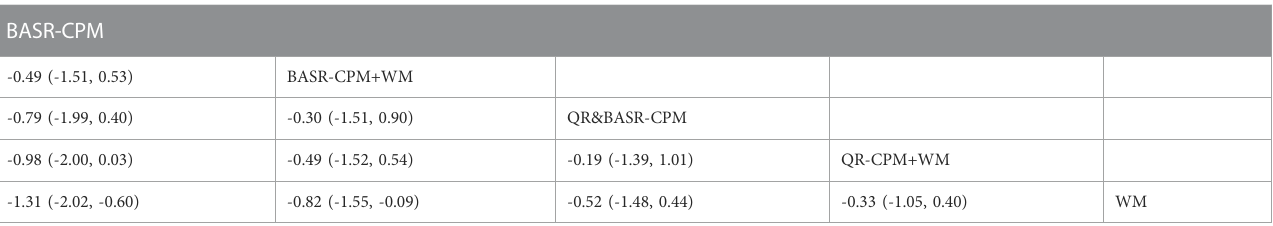
TABLE 9 Results of network meta-analysis for